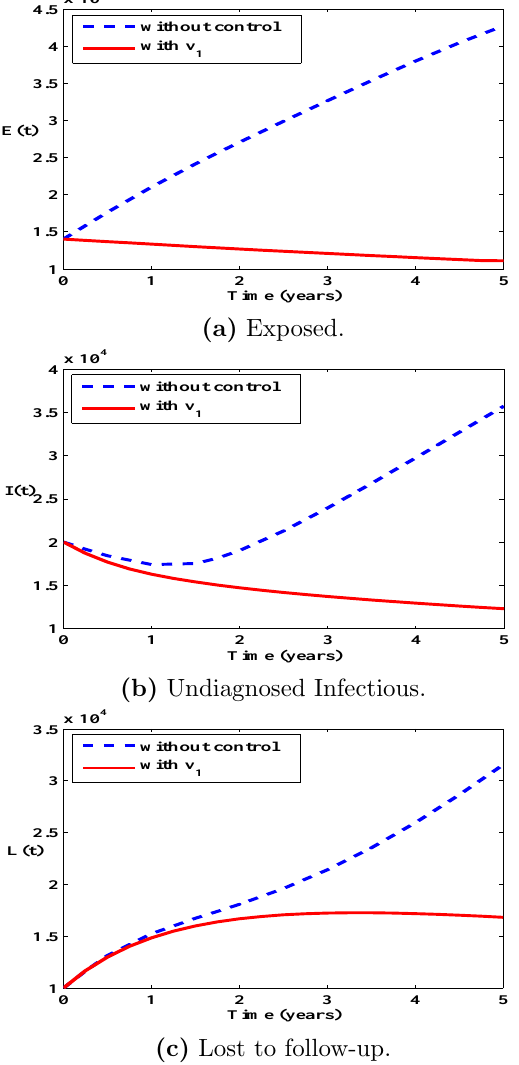
Figure 4. Number of E , I and L with control v 1 and without